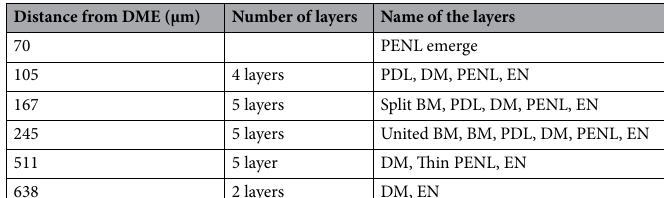
Distance from DME